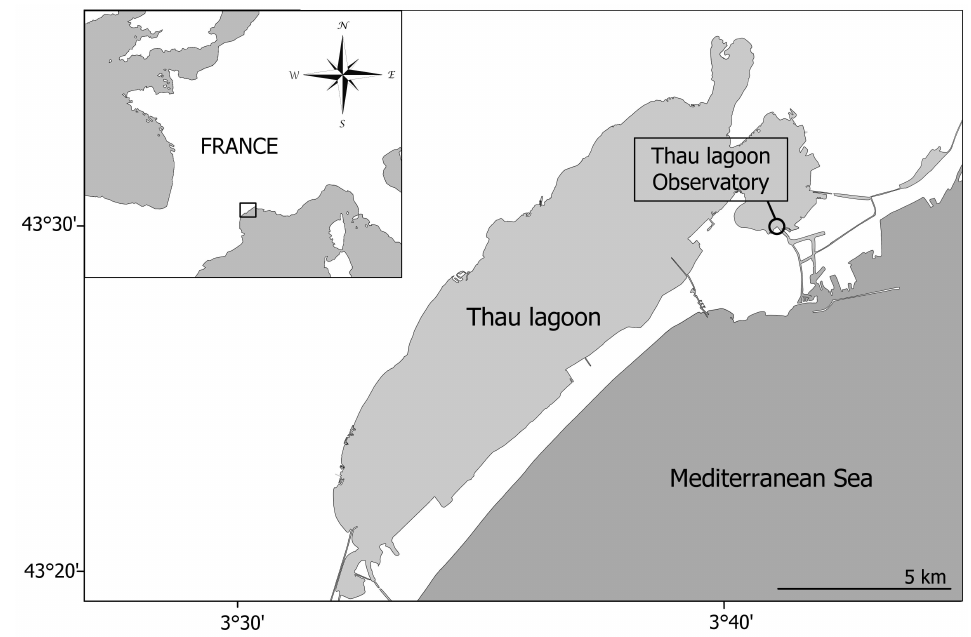
Figure 1. Area of sampling and experiment in Thau Lagoon Observatory (France) in the northwestern Mediterranean Sea.